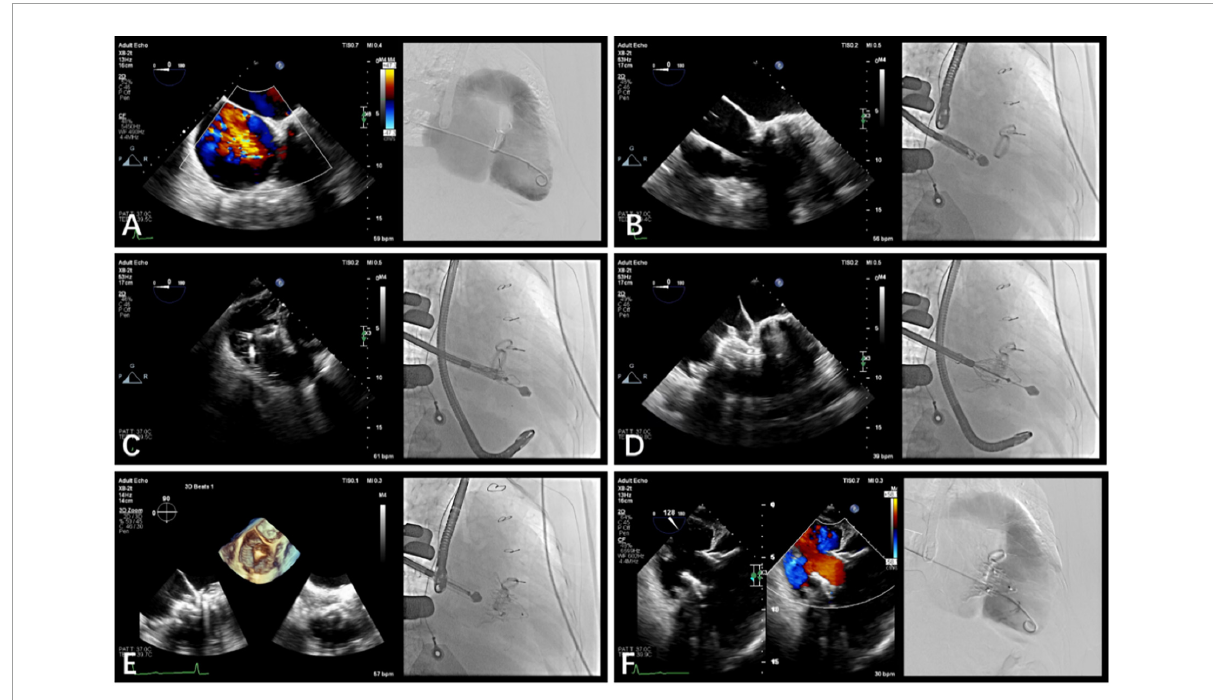
FIGURE3 Guidance using transesophageal echocardiography (TEE) and fluoroscopic imaging in transcatheter tricuspid valve replacement. (A) TEE and fluoroscopy showed severe tricuspid re-gurgitation. (B) LuX-Valve guided by TEE was used to deliver the bioprosthesis to TA via the right intercostal approach. (C) The delivery system released the interventricular anchor and 2 graspers, and the graspers were guided by TEE to clamp the anterior leaflet. (D) The annulus skirt and the atrium disc were released in turn, and the position of the implant was adjusted by TEE to ensure that there was no obvious paravalvular leakage. (E) The bioprosthesis was completely re-leased after fixation with the interventricular anchor. (F) Postoperative computerized tomography angiography and TEE showed that tricuspid regurgitation disappeared